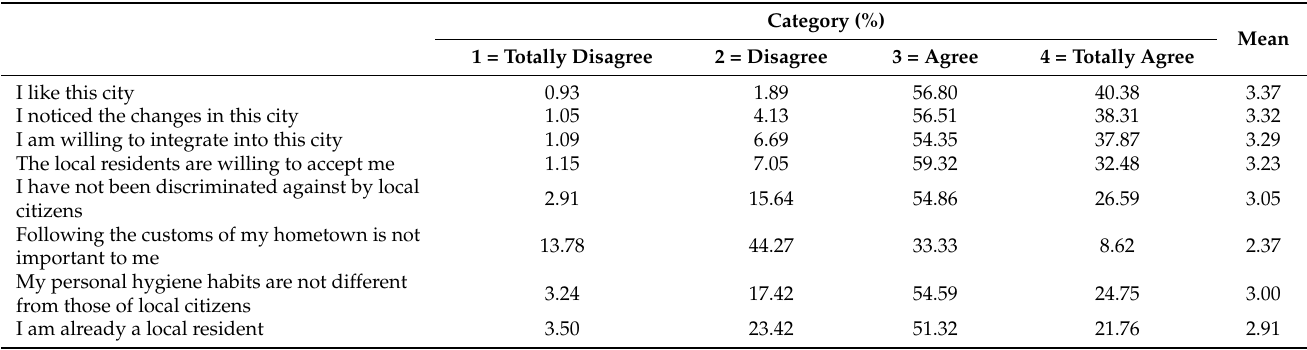
Table A1. Distribution of the sub-indexes of social integration.